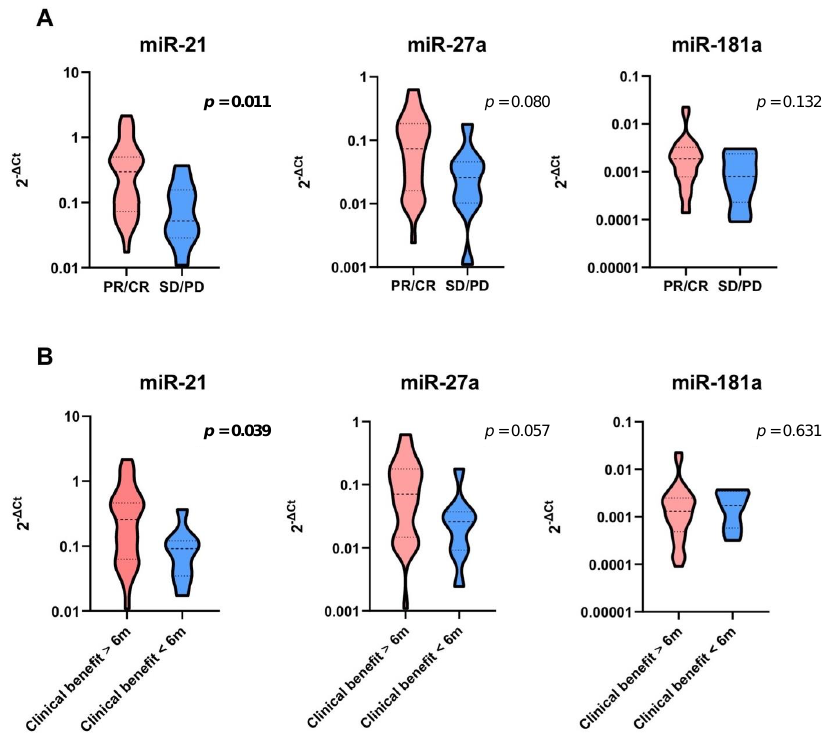
Figure 2. Basal miRNA expression and correlation with EGFR-TKI response ( A ) and duration of clinical benefit ( B ). Significant p values are in bold. Dashed lines represent the median values. Dotted lines represent the upper and lower